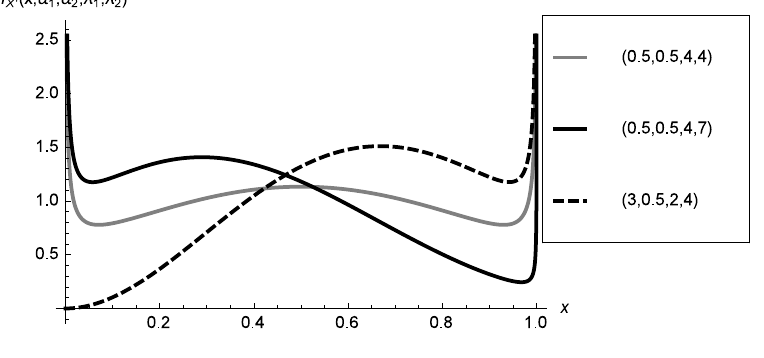
Figure 2 { Plots of the density of X ′ (cid:24) DNCB ( (cid:11) 1 ; (cid:11) 2 ; (cid:21) 1 ; (cid:21) 2 ) for selected values of ( (cid:11) 1 ; (cid:11) 2 ; (cid:21) 1 ; (cid:21) 2